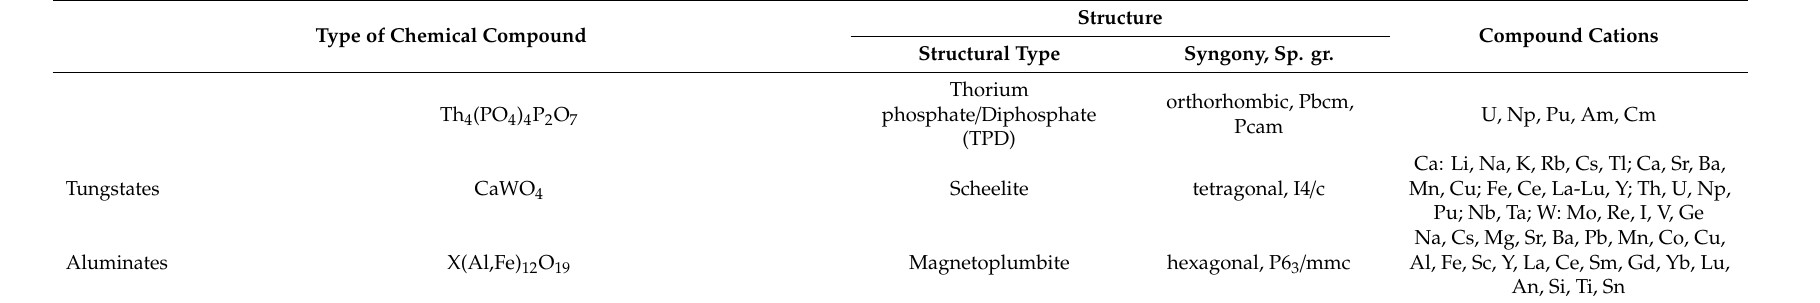
Table 1. Crystalline ceramic materials as potential forms for nuclear waste